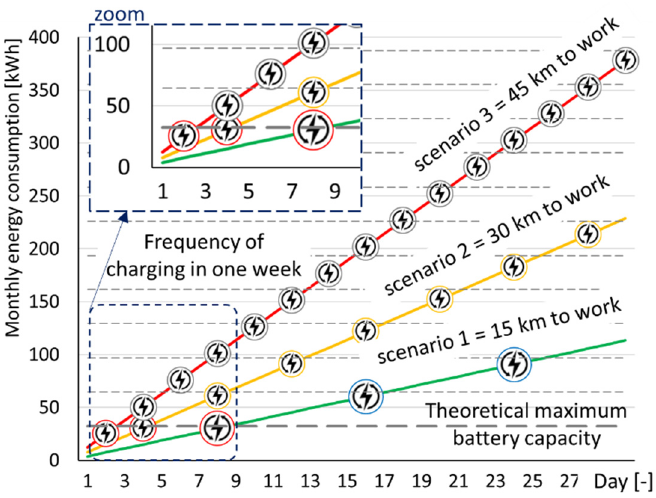
Figure 18. Frequency of charging an electric vehicle in the presented scenarios depending on the distance travelled by the